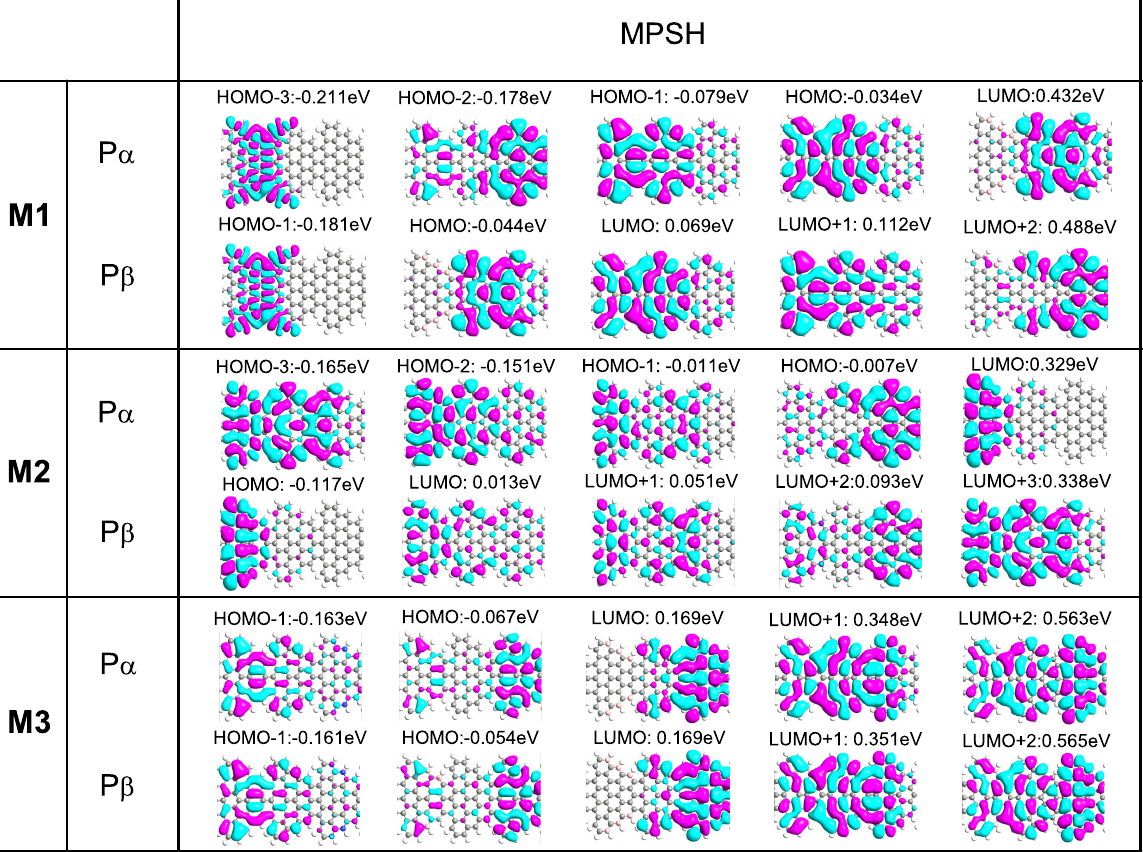
Figure 4. (Color online) The spatial distribution of the MPSH for M1-M3 at zero bias in P